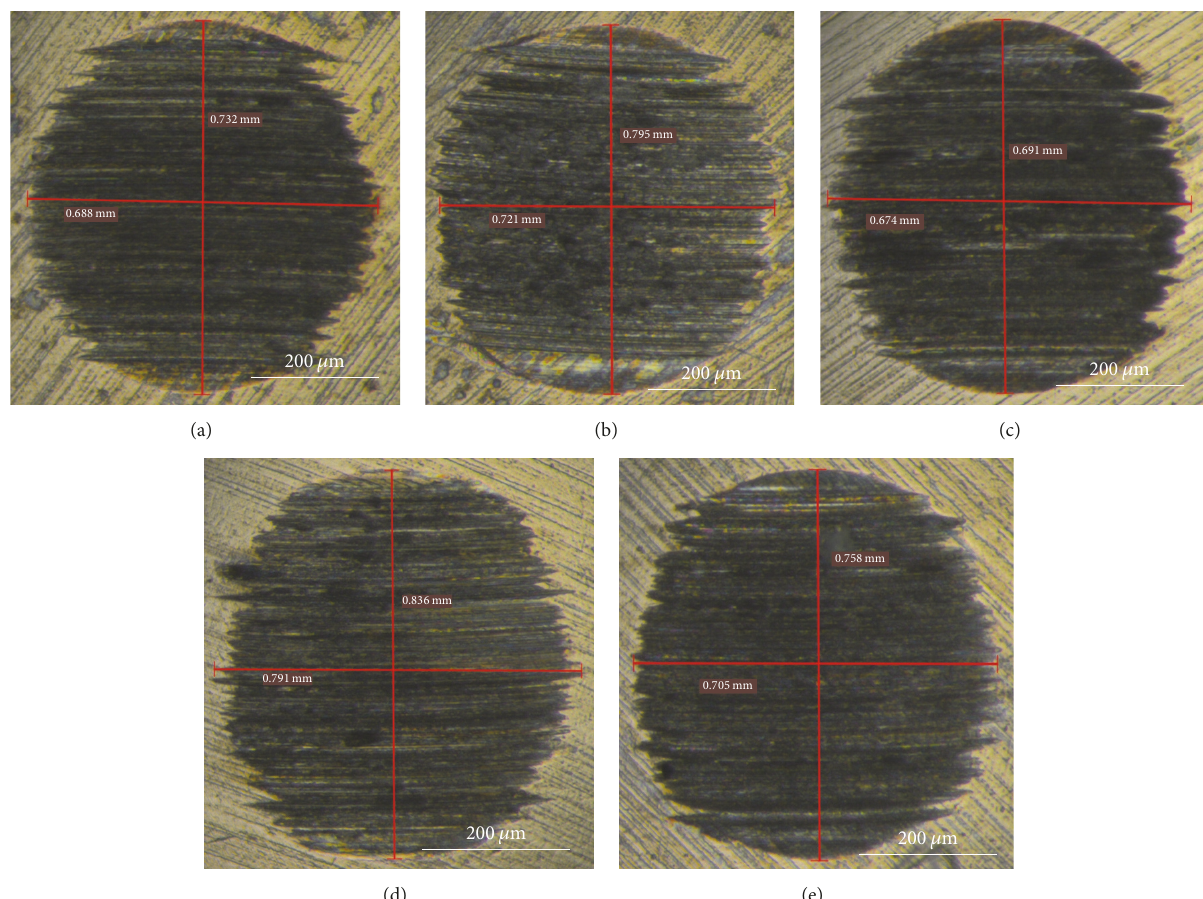
Figure 7: Wear scar diameters for the lubricants (a) L 1 , (b) L 2 , (c) L 3 , (d) L 4 , and (e) L 5